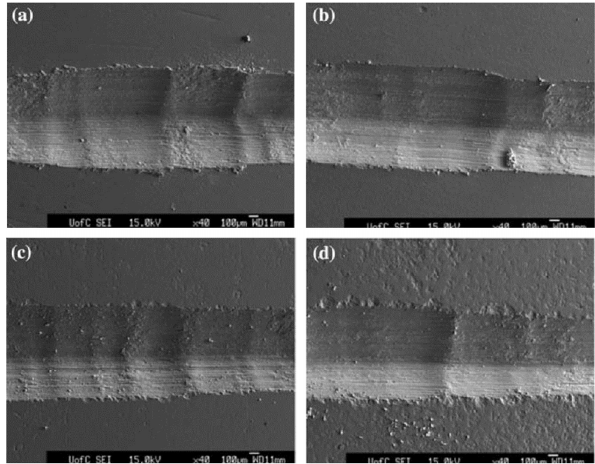
Fig. 15 Metallographic images of the wear tracks developed on the Ti64 test plate surface ST at 1,000 ° C (for 30 min): (a) as received Ti64 specimen; (b) quenched in oil; (c) quenched in water; (d) quenched in N 2 . Reproduced with permission from Ref. [19]. Copyright Springer Nature, 2007.